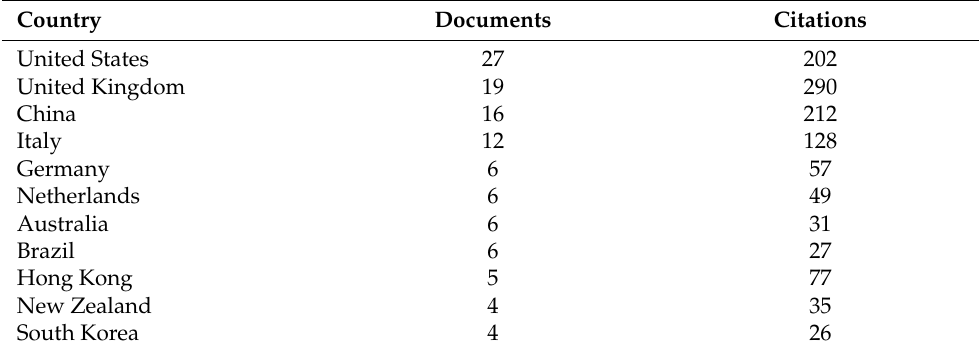
Table 1. Distribution of articles and citations in countries with more than three documents.